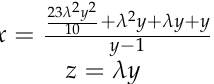
Figure 6. The connecting curves of System (1) for different k values and associated attractors. It is shown that the connecting curves represent the structure of the attractors, and since the structure of attractors did not change majorly, with different k values, the curves remain approximately unchanged.